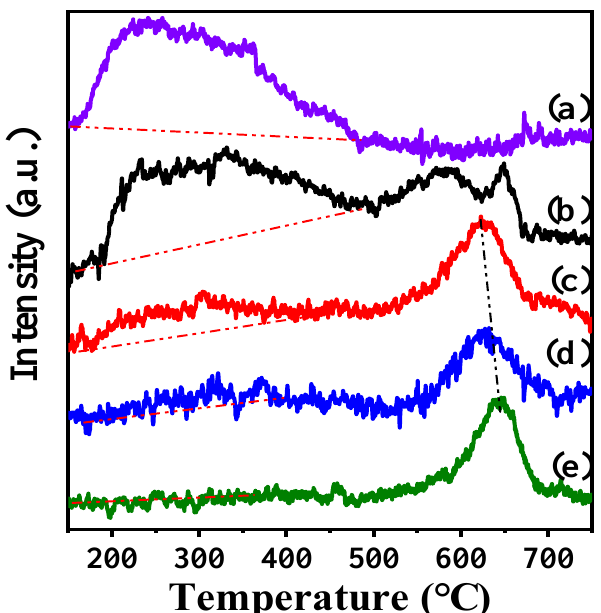
Figure 5. NH 3 -TPD profiles of ( a ) TiO 2 , ( b ) NiO/Ti-500C, ( c ) NiO/Ti-600C, ( d ) NiO/Ti-700C, ( e ) NiO/Ti-800C.